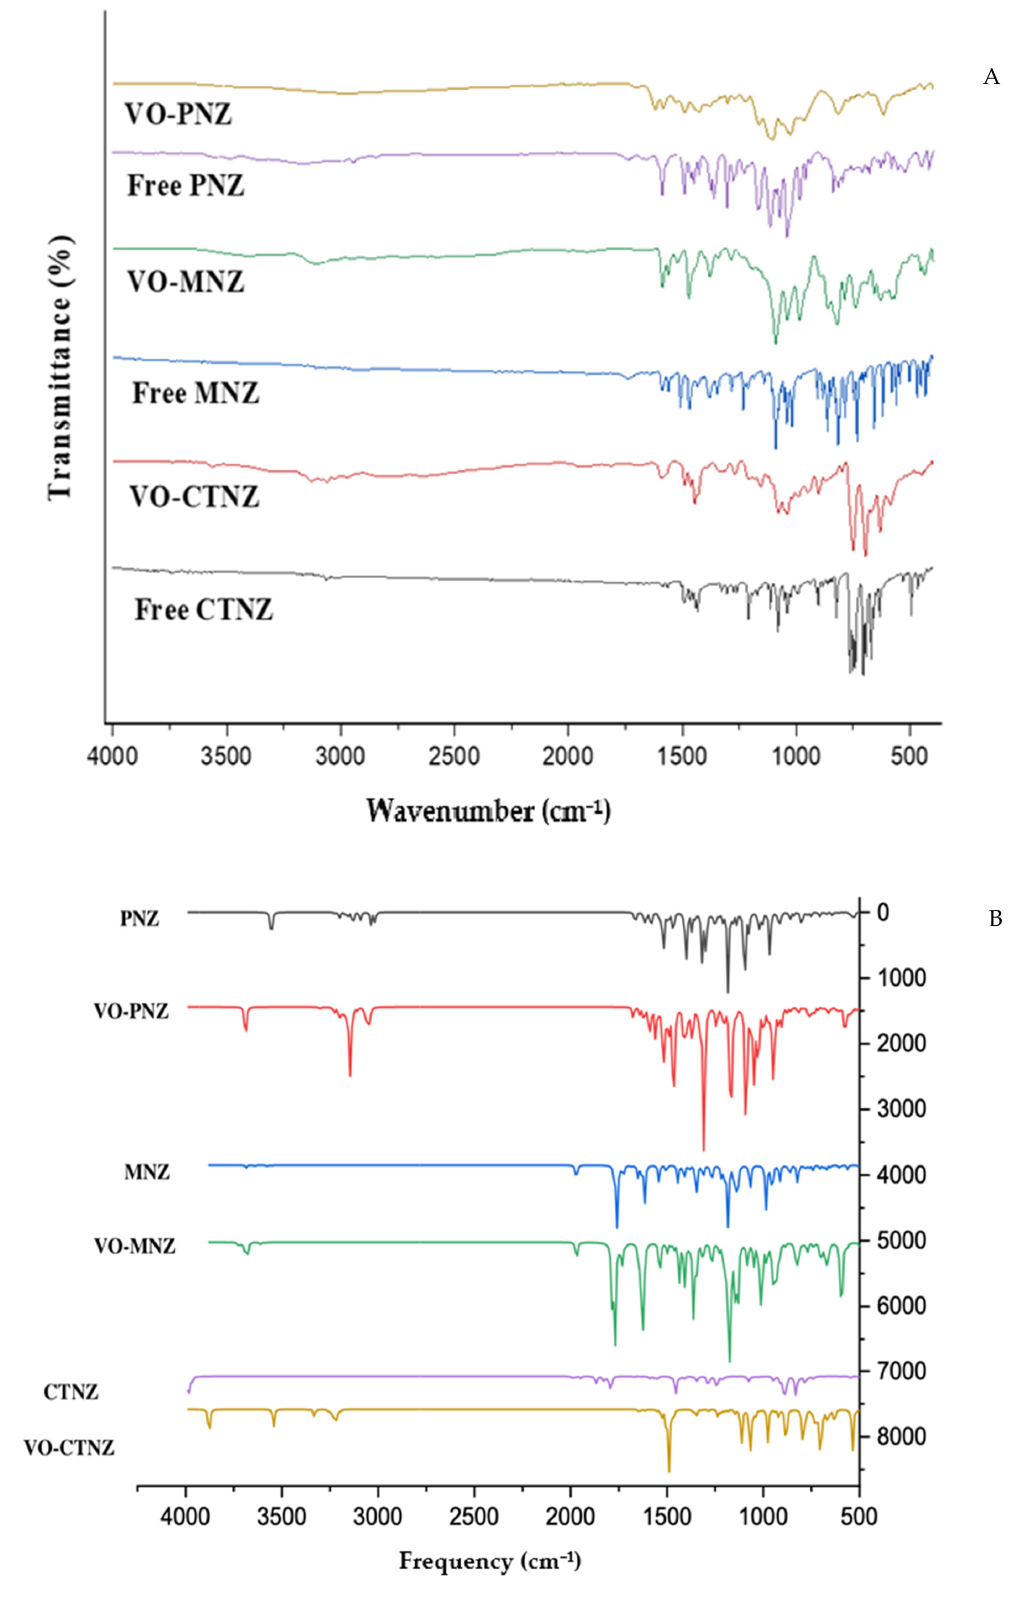
Figure 2. A comparison of the experimental ( A ) and theoretical ( B ) using DFT/ B3LYP IR spectra for the free ligands and the oxidovanadium(IV)